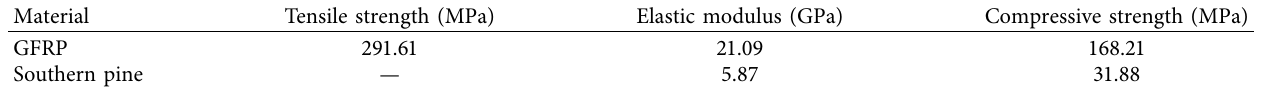
Table 1: Mechanical properties of the GFRP and southern pine.